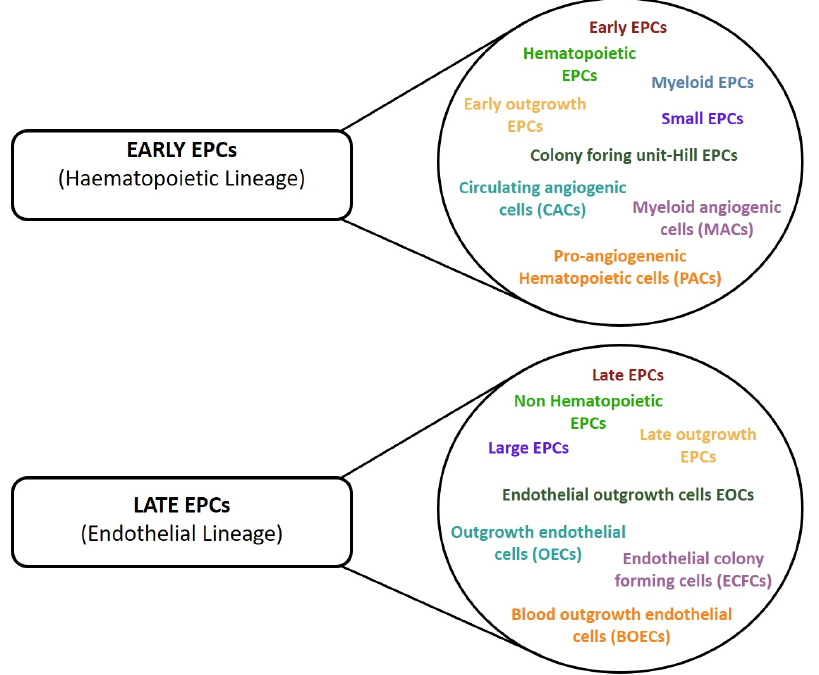
Figure 3. Different nomenclature used in the studies to define cells with pro-angiogenic properties. The cells have been divided into two group according to their lineage phenotype.